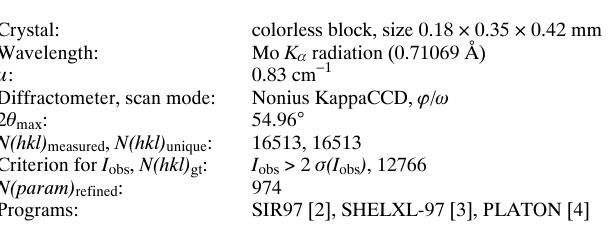
Table 1. D a t a collection a nd h a ndling.